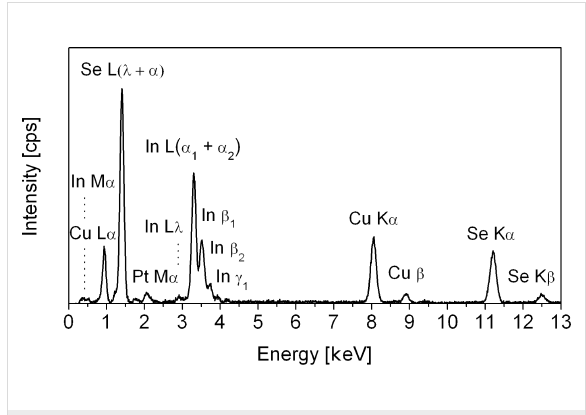
Figure 2: EDX analysis of CuInSe 2 nanorod arrays; Pt-signal origi- nates from the sputtered Pt/Pd alloy.